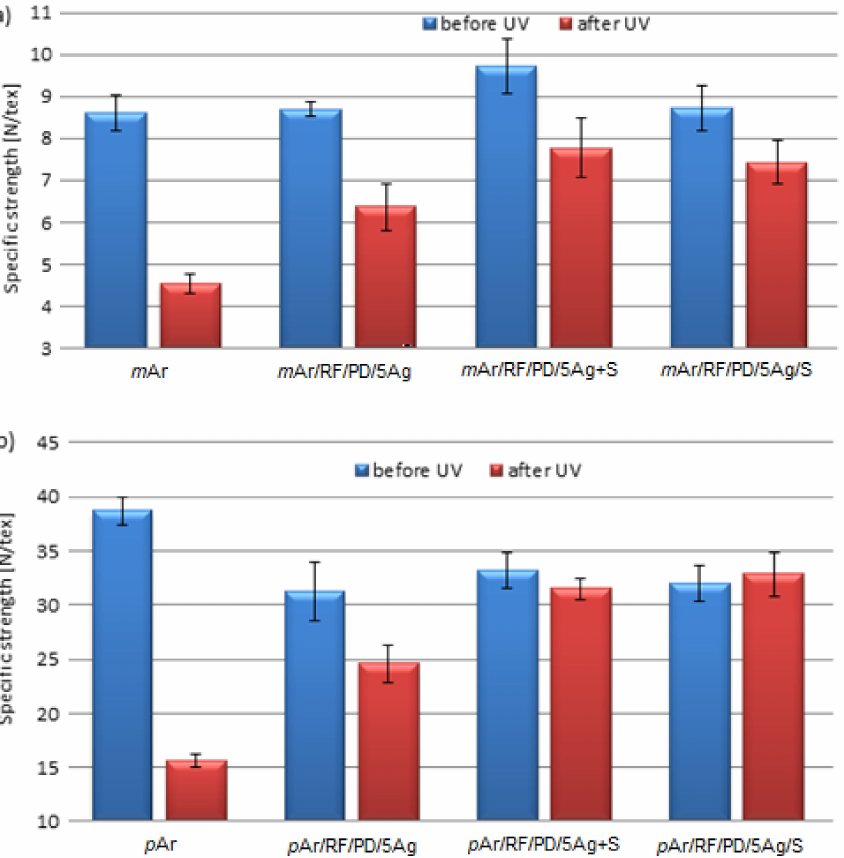
Figure 10. Specific strength of unmodified and modified m Ar ( a ) and p Ar ( b ) fabrics before and after UV irradiation (365 nm, 96